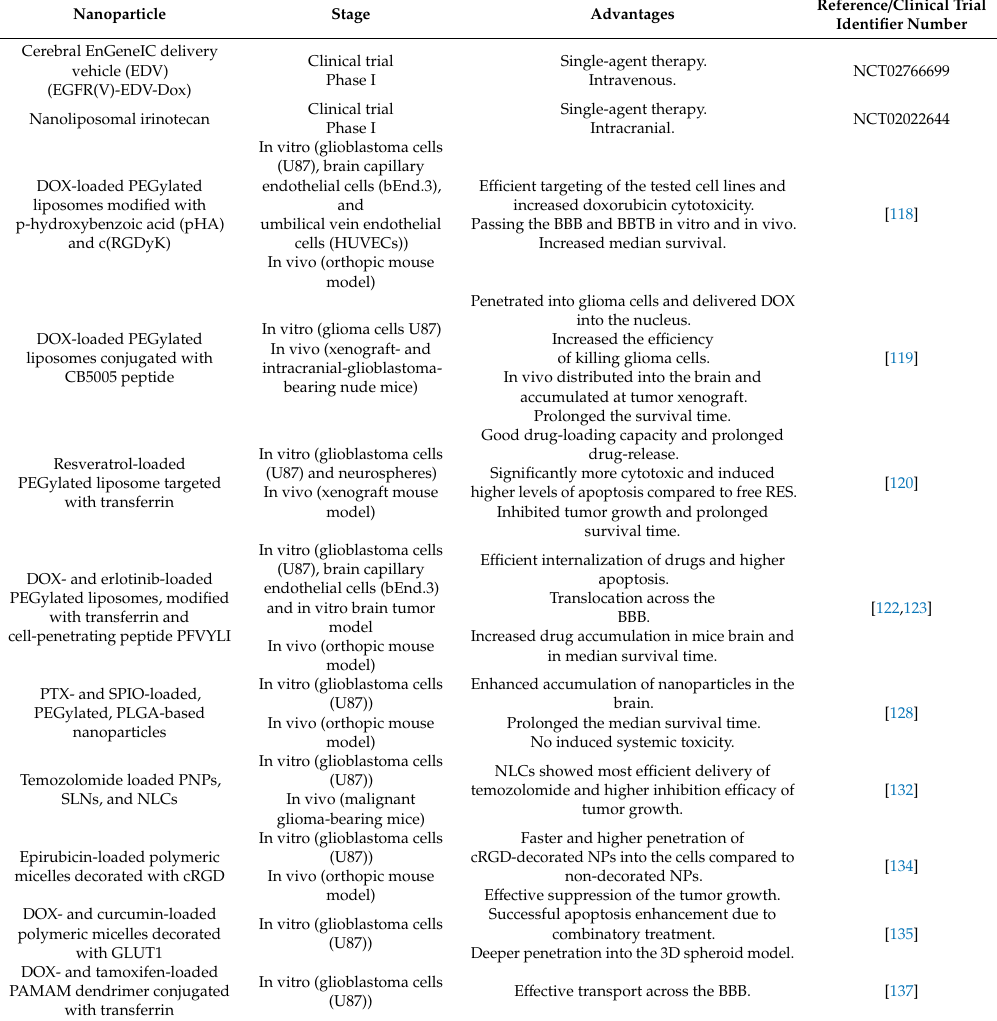
Table 3. Selected studies of nanoparticles currently being tested for